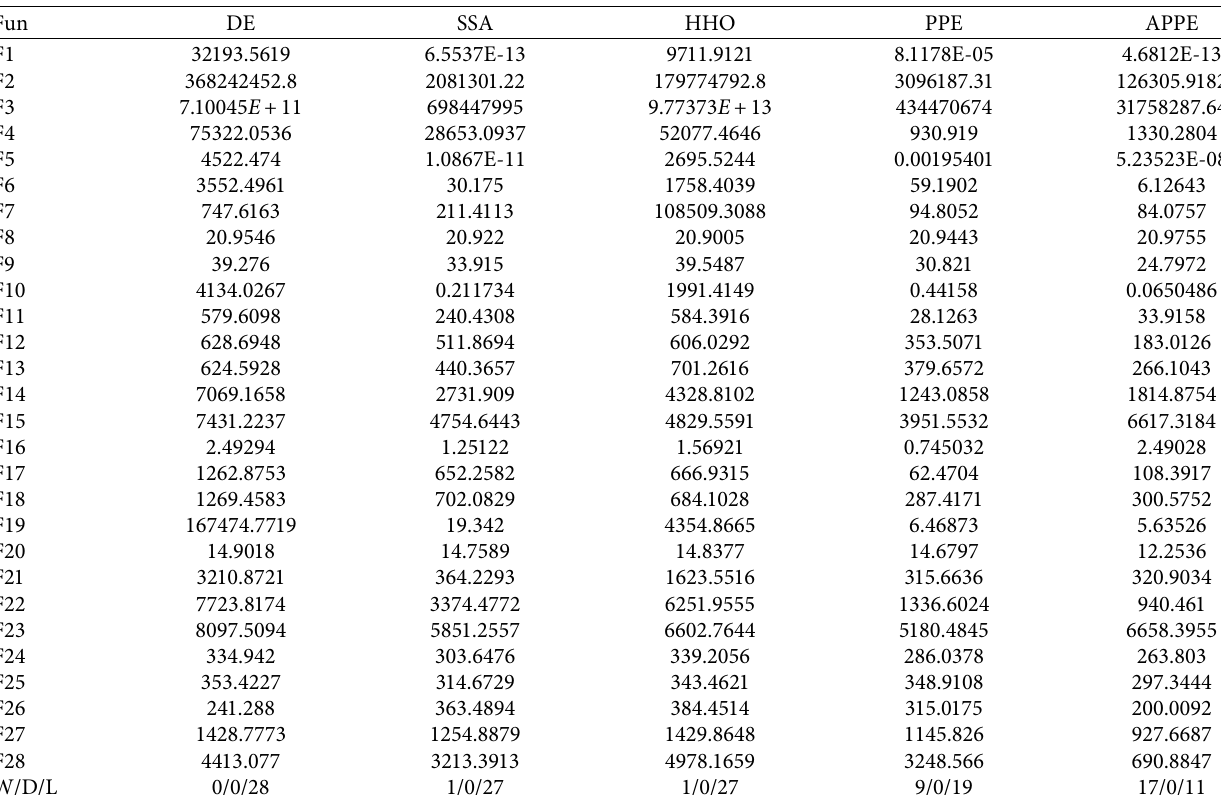
Table 7: Comparison of the mean result of 51 runs on 30D in 28 benchmark functions.